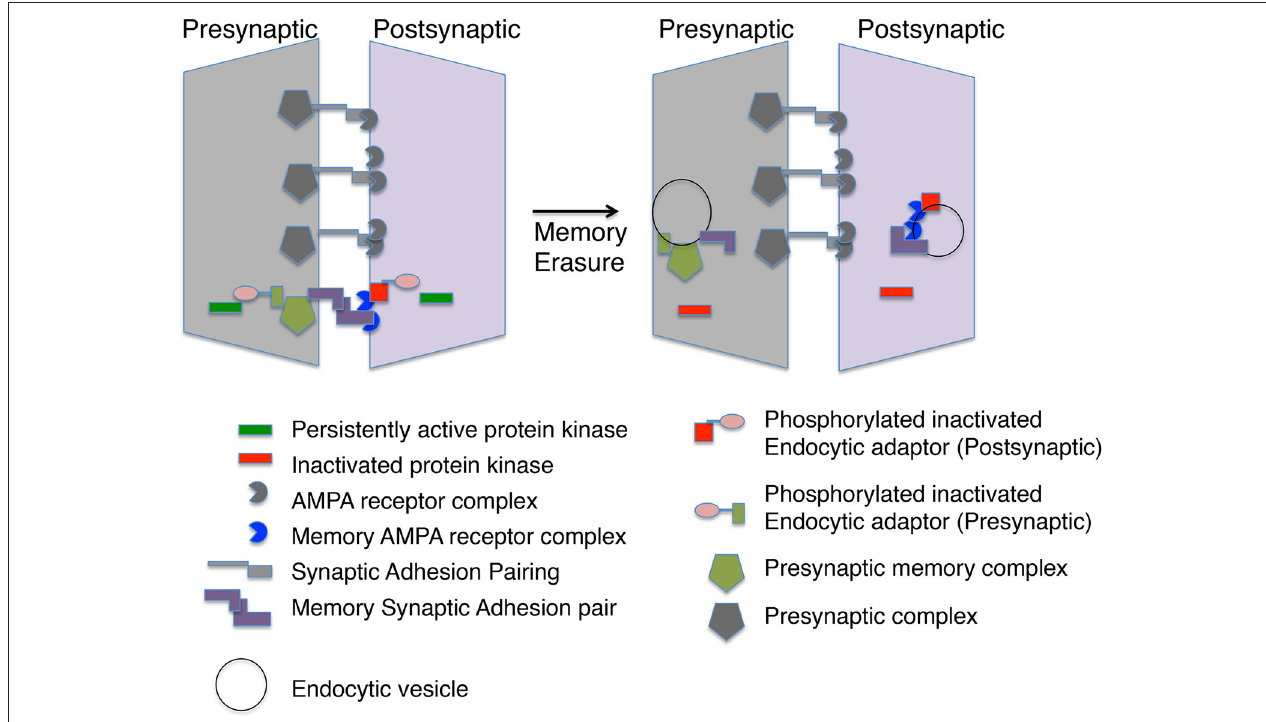
FIGURE 2 | A memory module at a synapse. The molecular memory complex is portrayed as a module with basal synaptic complexes at one synaptic connection. The molecular memory complex has memory-specific synaptic adhesion proteins, AMPA receptor complexes and presynaptic complexes. A persistent protein kinase is continually phosphorylating an endocytic adaptor protein preventing endocytosis of the molecular memory complex. Inactivation of the persistent protein kinase leads to endocytosis of the molecular memory complex in both the presynaptic and postsynaptic neuron.